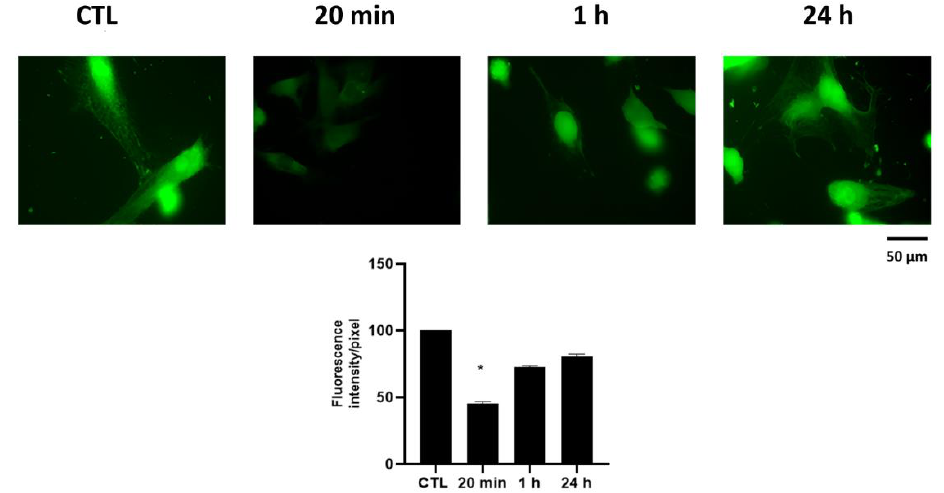
Figure 8. Effects of HPE DMSO on intracellular Ca 2+ concentration. Cells were treated with 0.1 mg/mL HPE DMSO for 20 min, 1 h and 24 h, then the amount of intracellular Ca 2+ concentration was measured by Calcium Green-1 AM. The densitometric analysis (bottom) was performed by ImageJ. Results are expressed as mean ± SEM of data obtained by three independent experiments. * p < 0.05 vs. CTL.